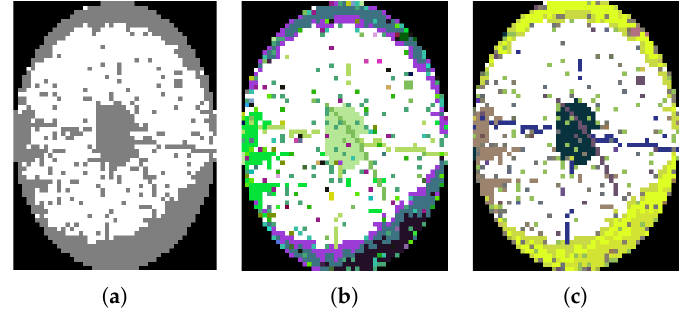
Figure 7. Various visualization methods in WBM: ( a ) Binarization, ( b ) Random RGB, ( c ) Bin2Vec.